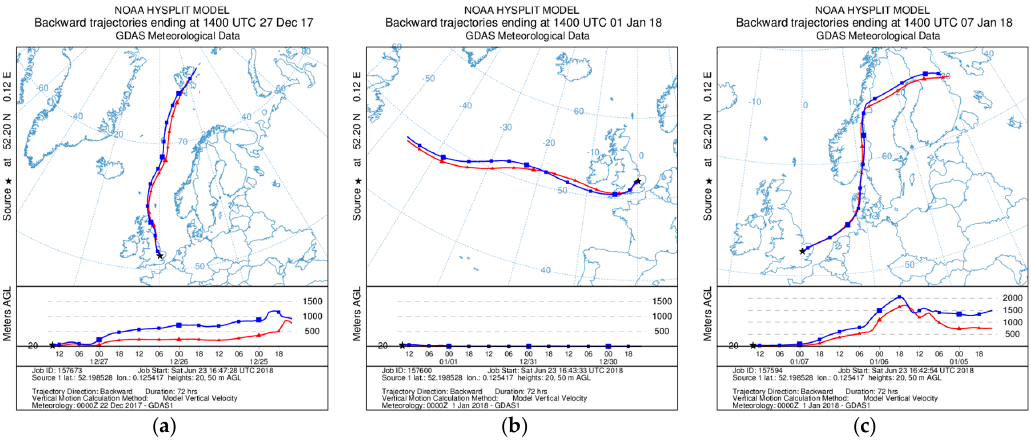
Figure 13. Ready Hysplit air mass trajectories plots ending in Cambridge (UK). ( a ) 27 December 2017; ( b ) 1 January 2018; ( c ) 7 January 2018. The blue and red lines correspond to trajectories at 20 m and 50 m above ground level, respectively.